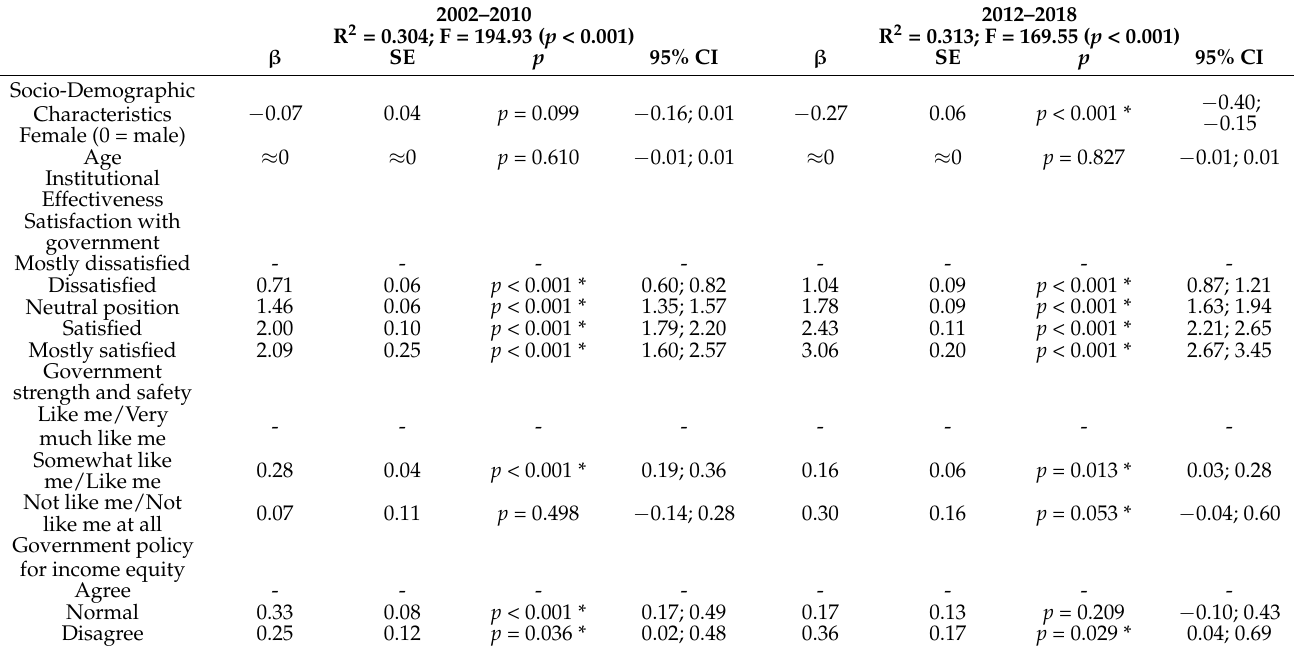
Figure 4. Perception of the healthcare considering education and subjective general health. Table 1. Political responsiveness (Model